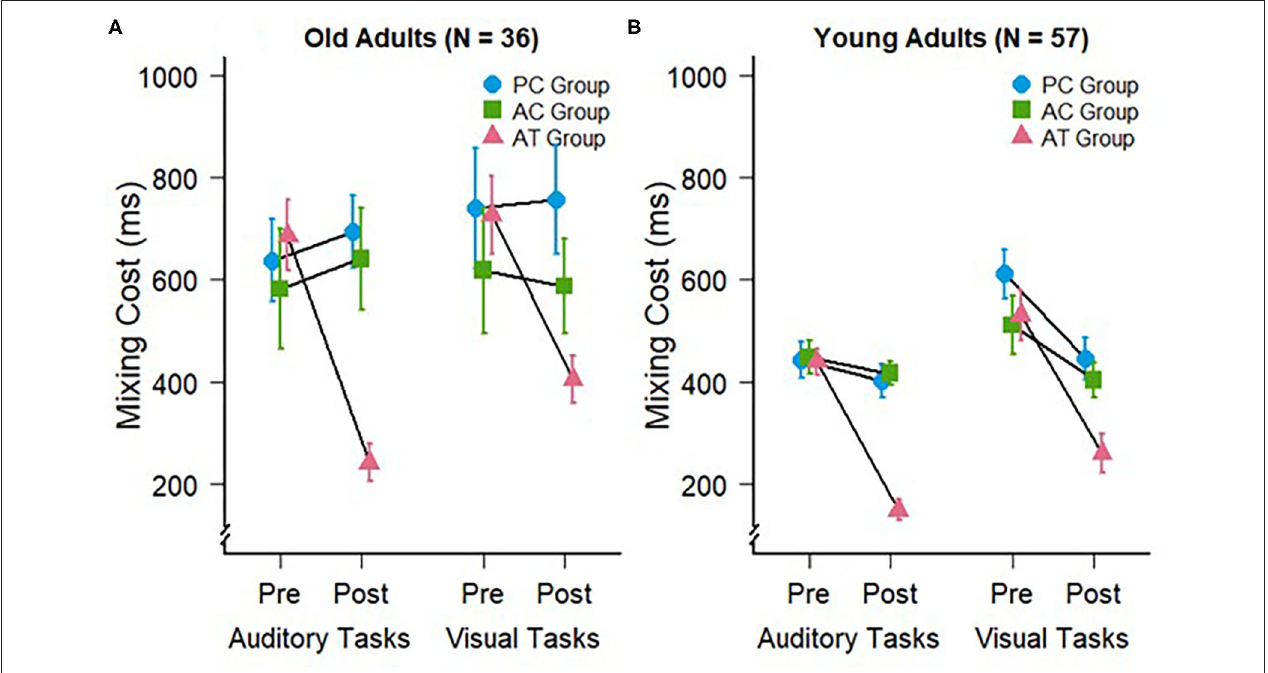
FIGURE 2 | Mixing costs during auditory (trained) and visual (untrained) task switching at pre- and post-test for (A) the old adults of the present study and (B) young adults of a previous study ( Kattner et al., 2019). Error bars depict standard errors of the mean.